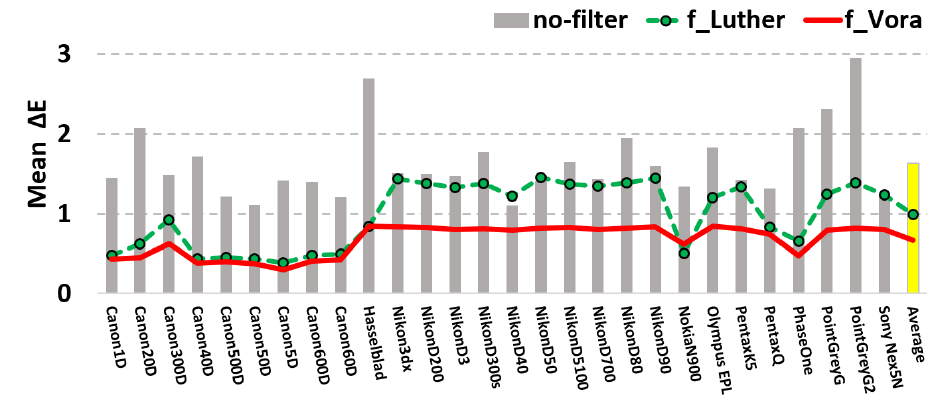
Figure 6. Mean ∆ E ∗ errors for 28 cameras. The grey-bars show the color errors for native cameras ab simply use color correction with no filter. The dashed green lines show the results by using the Luther-condition optimized filter. The results of the orthonormal-modified Luther optimized filters are plotted in solid red